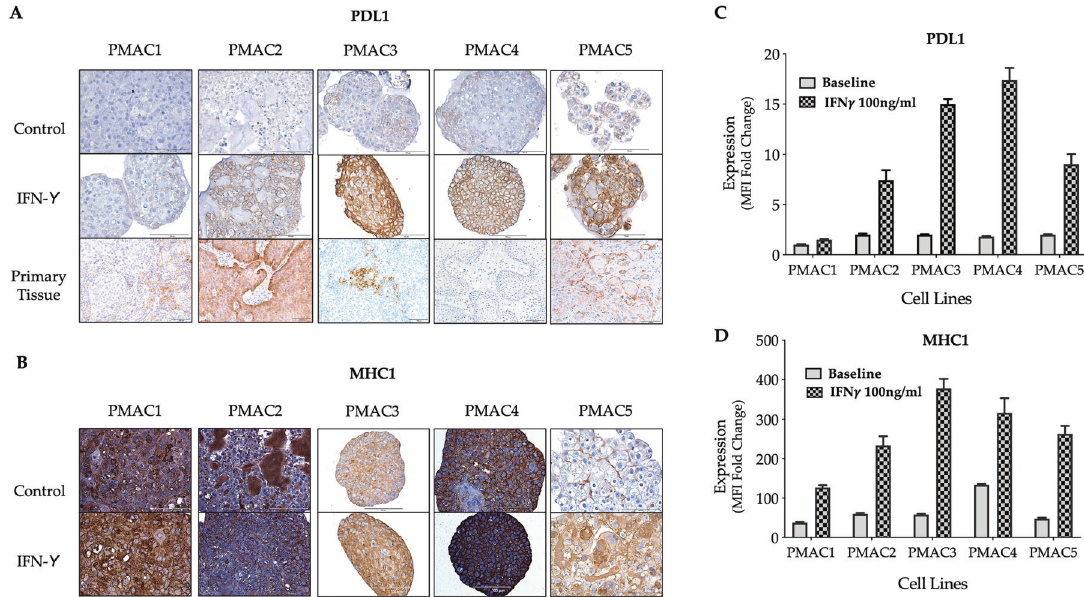
Fig. 6 MHC I & PD-L1 expression in anal cell lines and cell line tumouroids. The panel of ASCC cell line tumouroids were grown in matrigel and RPMI medium containing 10% FCS. After 5 days in culture the tumouroids were exposed to IFN- γ (100 ng/ml) for 48 h, following which they were retrieved, fi xed, embedded, sectioned and stained by IHC for A PD-L1 and B MHC I expression. Cells were counter stained with haematoxylin. The parent tumour tissue PD-L1 IHC staining was performed for comparison (Scale bar 100 μ m). C , D . Expression of PD-L1 and MHC I was also assessed by fl ow cytometry. Following seeding of cells 24 h prior, expression was assessed after growth in the absence (plain bar) and presence (checked bar) of 100 ng/ml IFN- γ for 48 h. Results are expressed as the fold change of the mean fl uorescent intensity (MFI) in relation to the respective isotype control (mean percentage of control ± SEM, n =